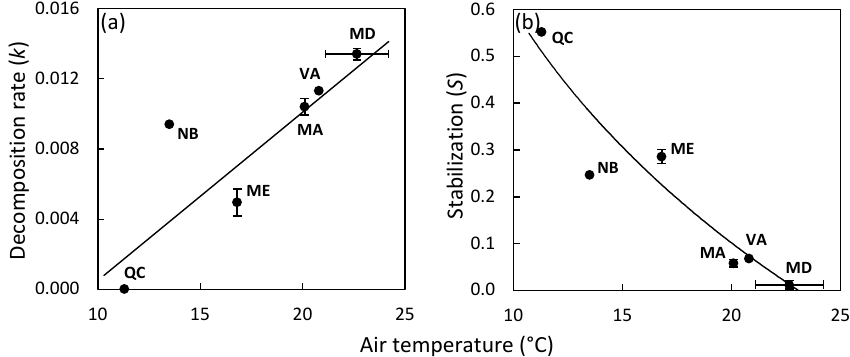
Figure 3. Site means of decomposition rate (a) and stabilization (b) versus mean air temperature of the deployment period shown for the 10 sites situated along the latitudinal gradient of the North American Atlantic coast; state abbreviations are shown (compare Table 1). Regression lines illustrate significant relationships; regression models with the lowest standard error of estimate (SEE) and highest R 2 are shown. Decomposition rate: y = 0 . 001 x − 0 . 0091; R 2 = 0 . 692; SEE = 0.003. Stabilization: y = − 0 . 712ln (x) + 2 . 2331; R 2 = 0 . 860; SEE = 0.070. Table 2. Spearman rank coefficients between the variables temperature, latitude, tidal amplitude, salinity class, k , and S (coefficients are bold typed at p ≤ 0 . 05) and comparisons of temperature ( ◦ C), latitude ( ◦ ), amplitude (m), k , and S between ecosystem types (mangrove vs. marsh) and soil types (mineral vs. organic) shown as site means ± SE, n = 30. Asterisks show results of Mann–Whitney U tests and